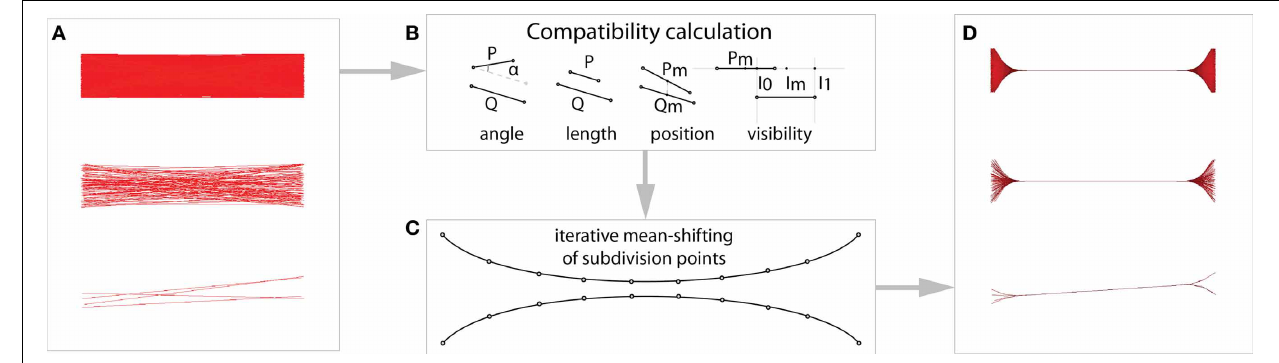
FIGURE 2 | (A) Edge-bundling groups together geometrically similar connexels. (B) First, a measure of similarity (compatibility) between connexels is calculated from four geometrical criteria: length, angle, distance, and overlap (based on Holten and van Wijk, 2009). (C) Mean-shift edge-bundling then